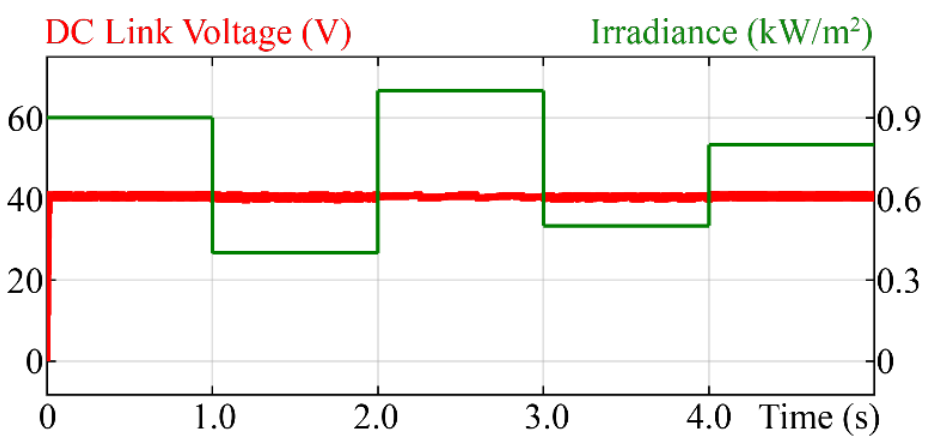
Figure 8. Boost converter voltage (V B ) vs. time under varying irradiances.